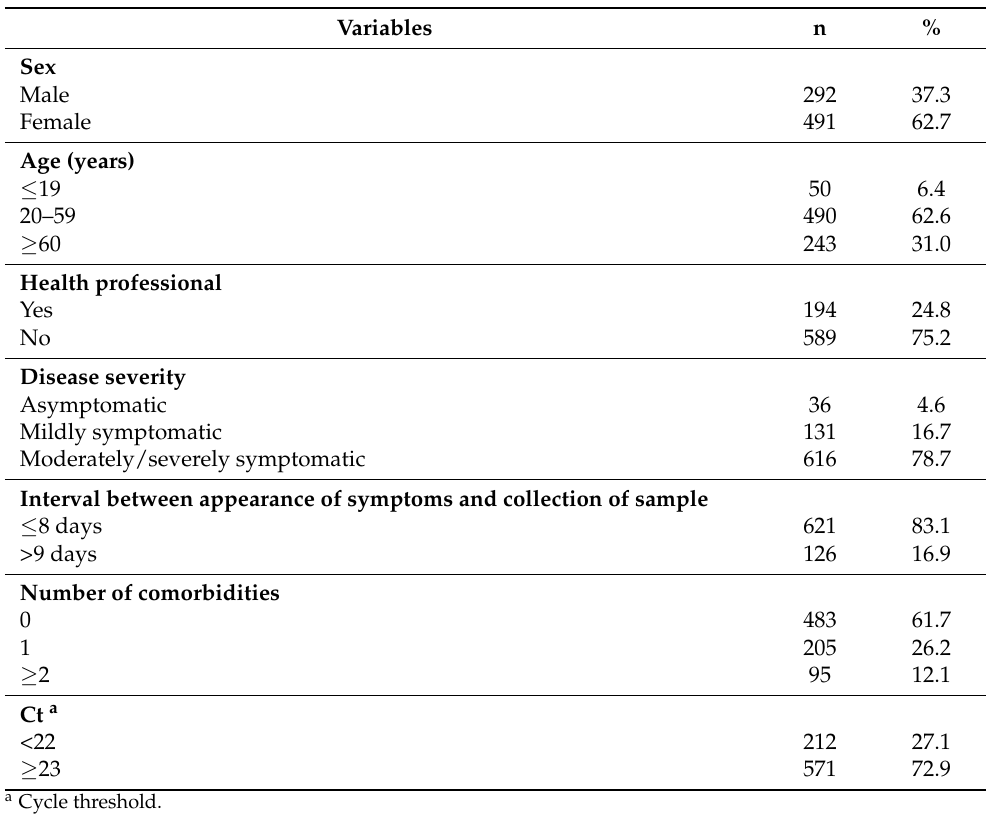
Table 2. Sociodemographic and clinical characteristics of COVID-19 patients in Vit ó ria da Conquista, BA,